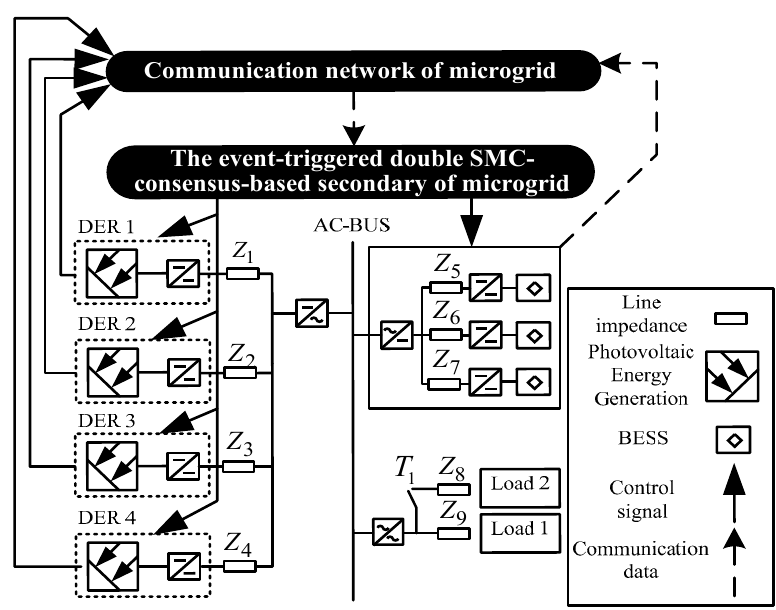
Figure 5. The related MG model in experiments.